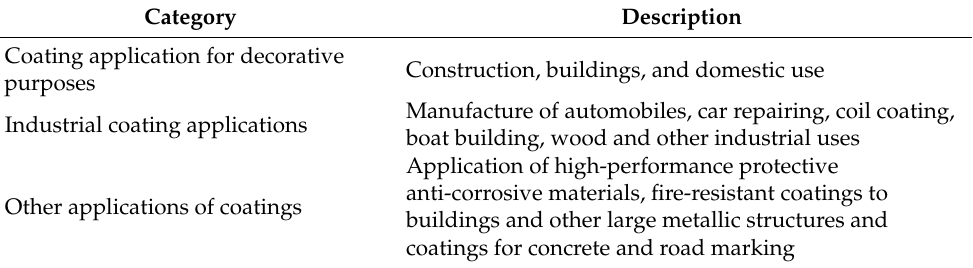
Table 3. Main categories with regard to the domestic use of solvents.